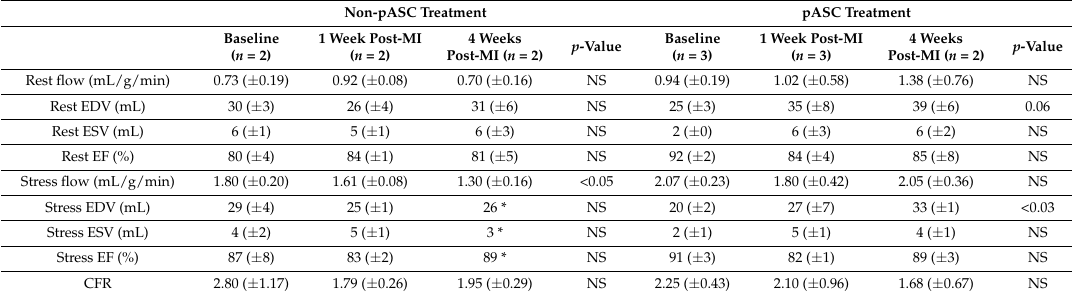
Table 1. Left ventricle function parameters and perfusion before and after induction of a myocardial infarction in pASC and non-pASC-treated minipigs measured by 82 Rb PET-CT. Non-pASCTreatment